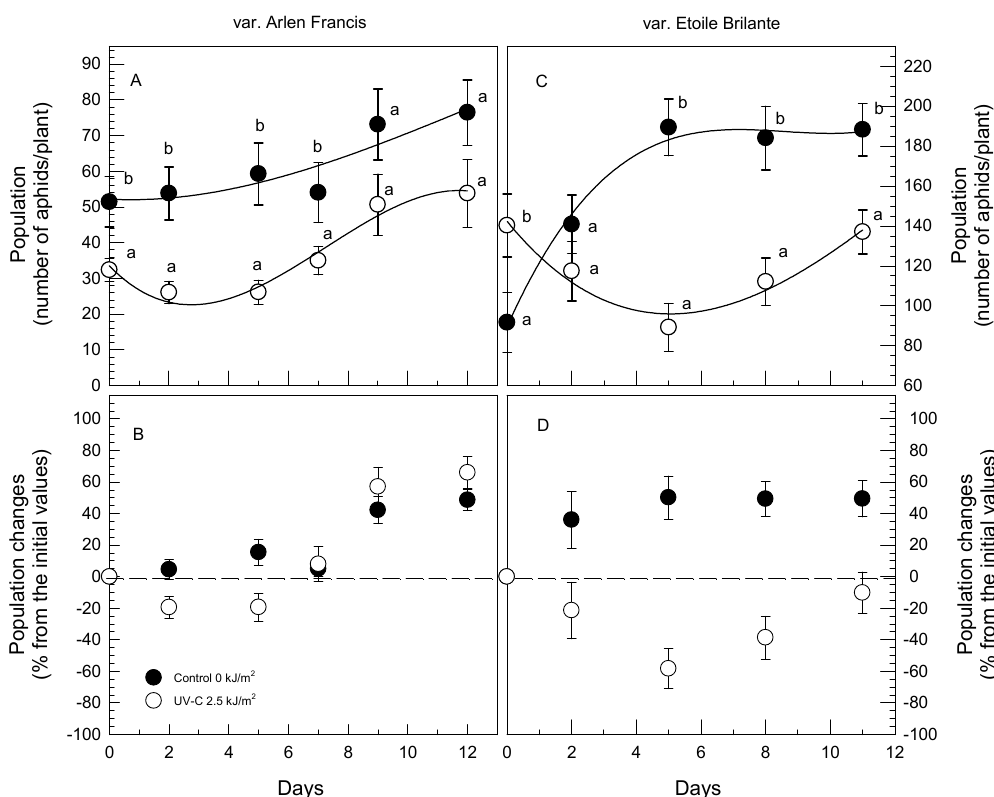
Figure 1. Population ( A , C ) (number of aphids/plant), population changes ( B , D ) (% from the initial values) of vars. “Arlen Francis” ( A , B ) and “Etoile Brilante” ( C , D ) rose plants irradiated with 2.5 kJ/m 2 of left untreated (controls) over a 3-week period during a greenhouse soil trial (GST). Data are means ± S.E. Different letters indicate the significant differences between treatments at p = 0.05. Cubic regression analysis (y = yo + ax + bx 2 + cx 3 ) were performed for the aphid population on “Arlen Francis” (A; ● : R = 0.83, y = 52.21 − 0.43x + 0.31x 2 − 0.01x 3 and ○ : R = 0.96, y = 33.54 − 8.58x +1.92x 2 + 0.09x 3 ) and “Etoile Brilante” (C; ● : R = 0.94, y = 142.27 − 19.81x + 2.39x 2 − 0.06x 3 and ○ : R = 0.99, y = 89.69 + 36.12x − 4.32x 2 + 0.17x 3 ) at p = 0.05.